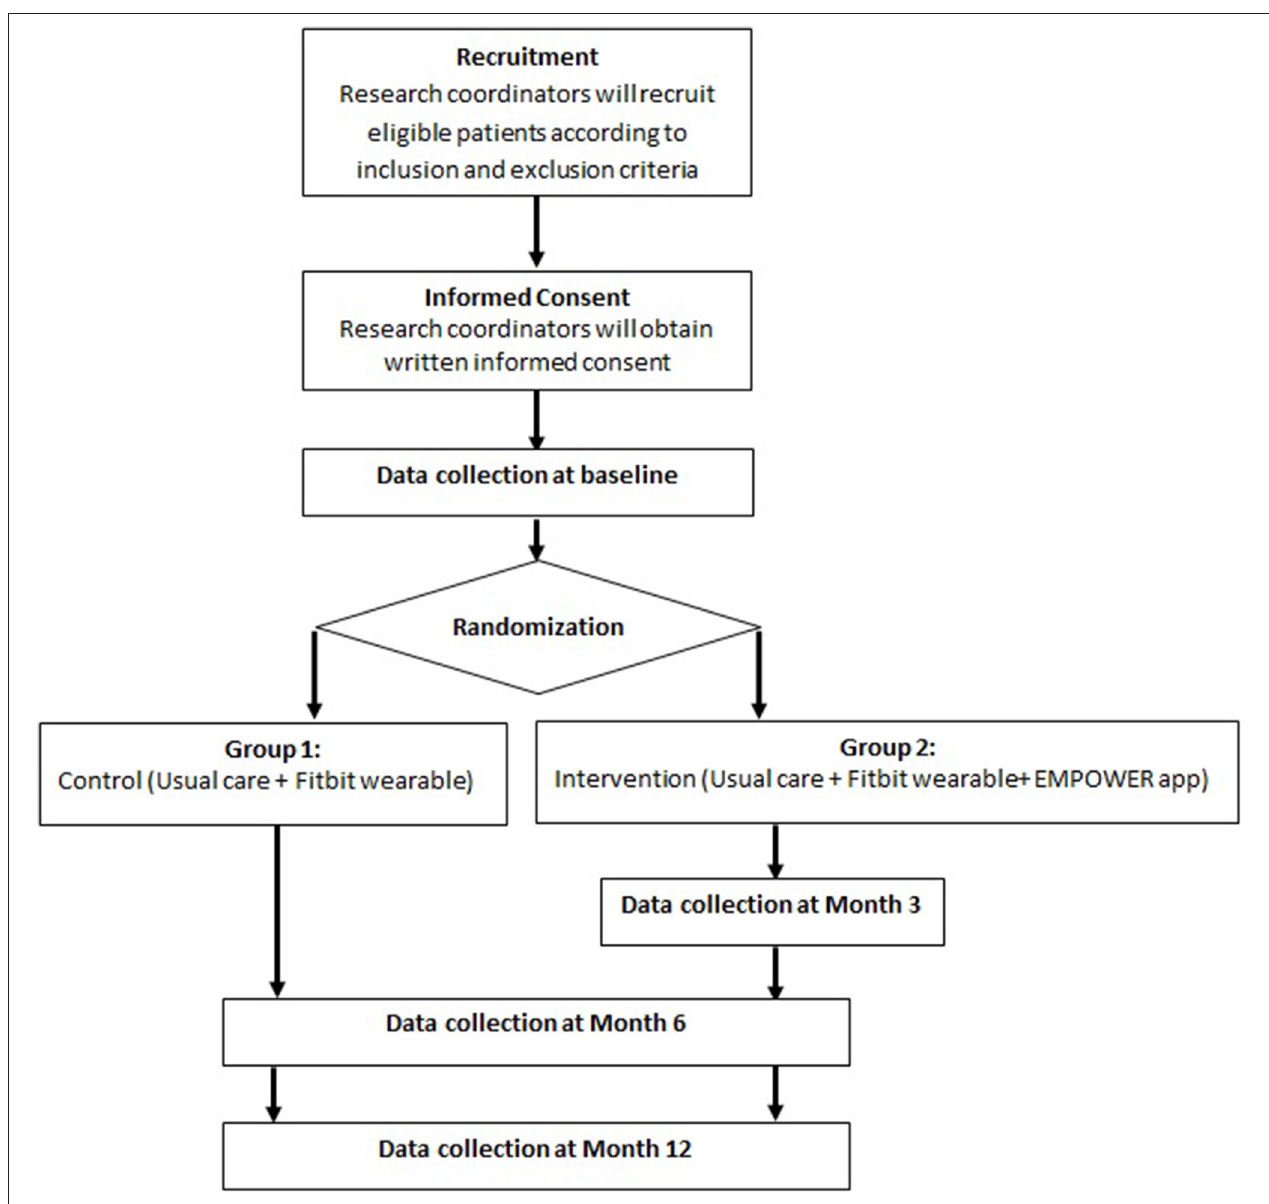
FIGURE 2 | Trial work plan. Follow-up will be performed at month 3, 6, and 12 after baseline visit.